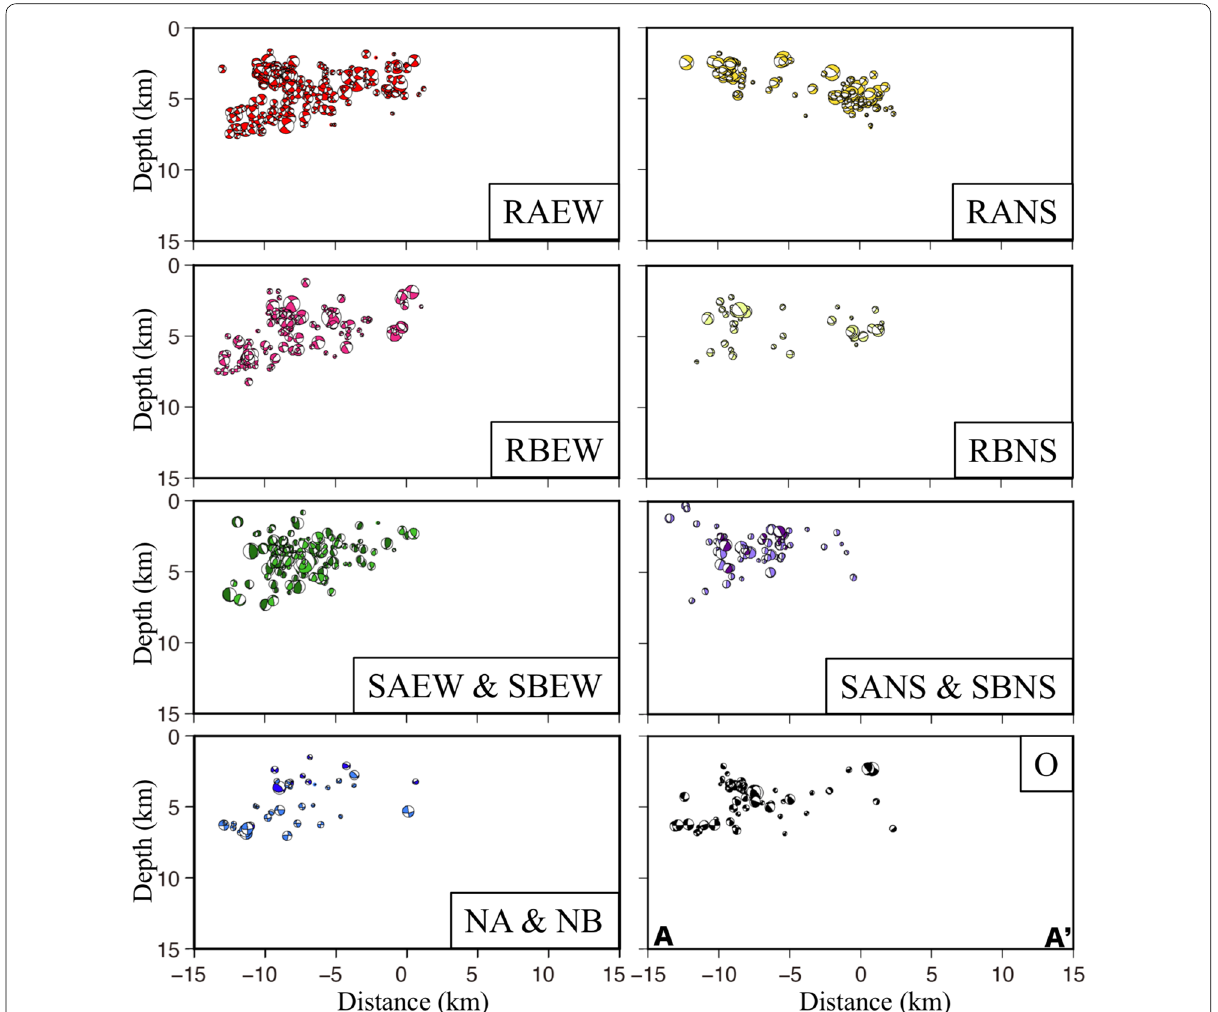
Fig. 4 Cross sections of focal mechanism distributions. Focal mechanisms of earthquakes in the black rectangle in Fig. 3c are projected onto the plane A – A’ . See the caption of Fig. 3 and the text for the classification of focal